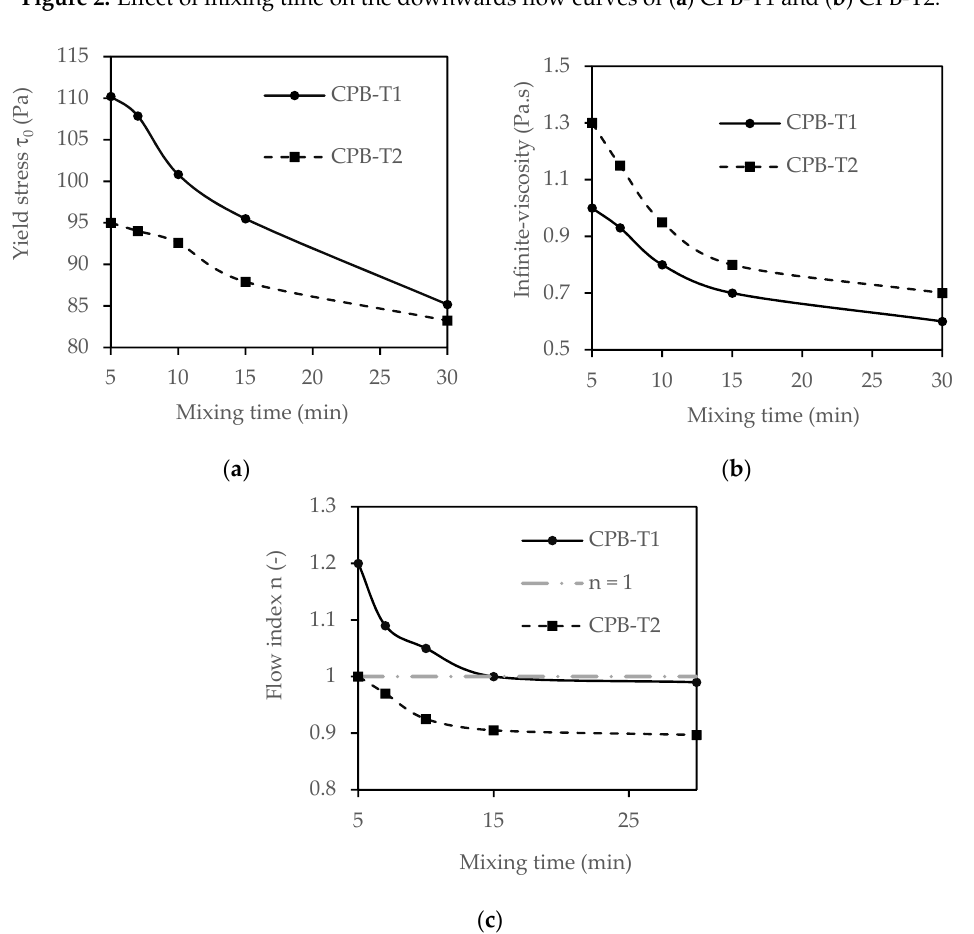
Figure 3. Effect of mixing time on ( a ) yield stress, ( b ) flow index and ( c ) infinite viscosity for CPB-T1 and CPB-T2 mixtures.